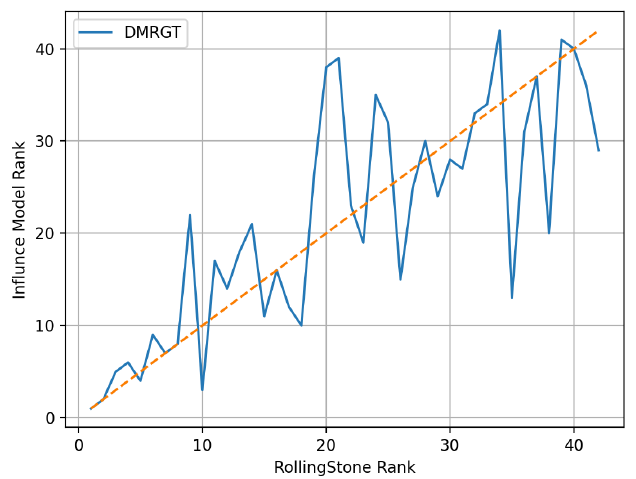
Figure 9. Comparison of DMRGT ranking and Rolling Stone ranking.